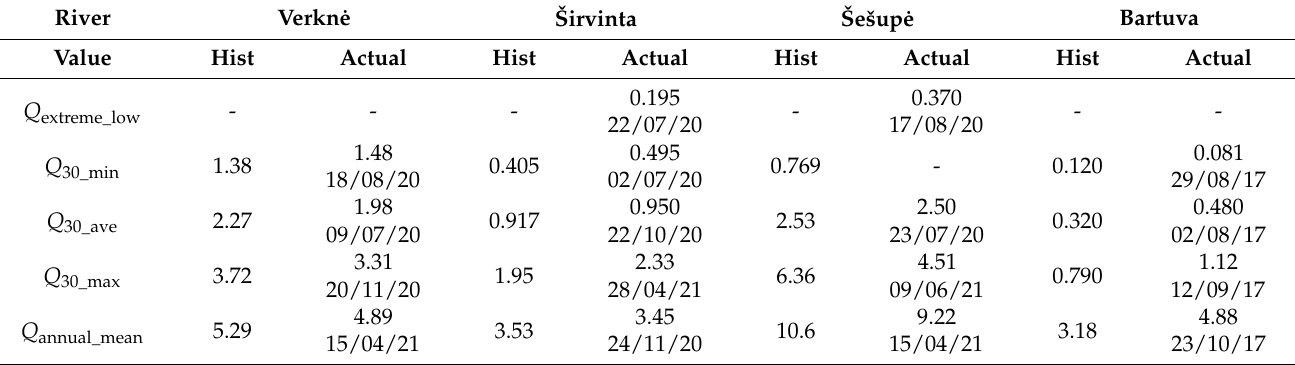
Table 3. Calculated target discharges according to historical observations (Hist) and actual discharges (Actual) that were measured during the field surveys of HMU mapping in the Verkn˙e, Širvinta, Šešup˙e, and Bartuva rivers on the specific dates